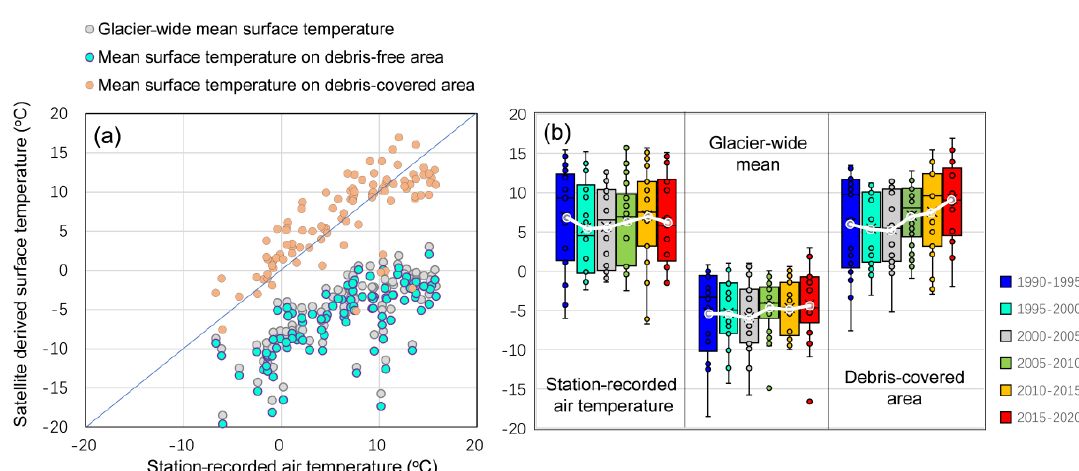
Figure 8. ( a ) Comparison between the station-recorded air temperature and satellite-derived glacier